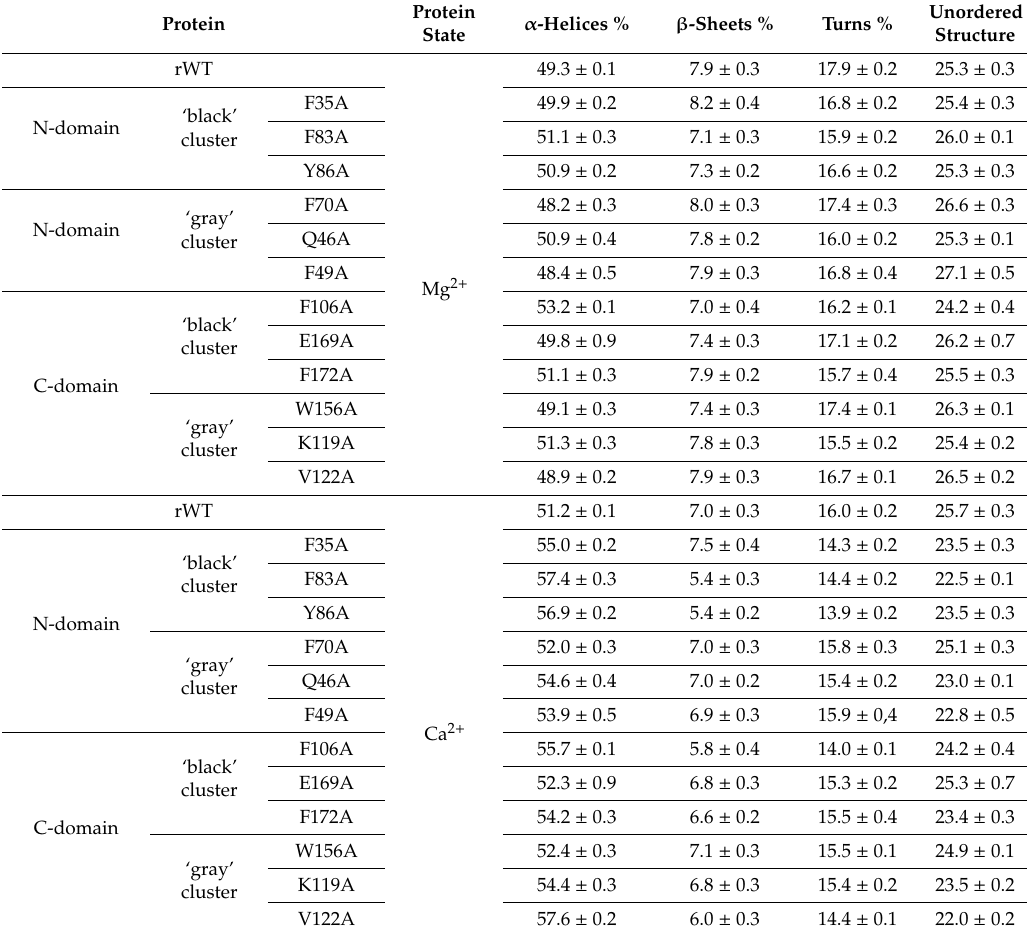
Table 2. Distribution of oligomeric forms of recombinant wild type human recoverin and its cluster mutants obtained from experiments on chemical crosslinking by glutaric aldehyde (0.02%) at 20 ◦